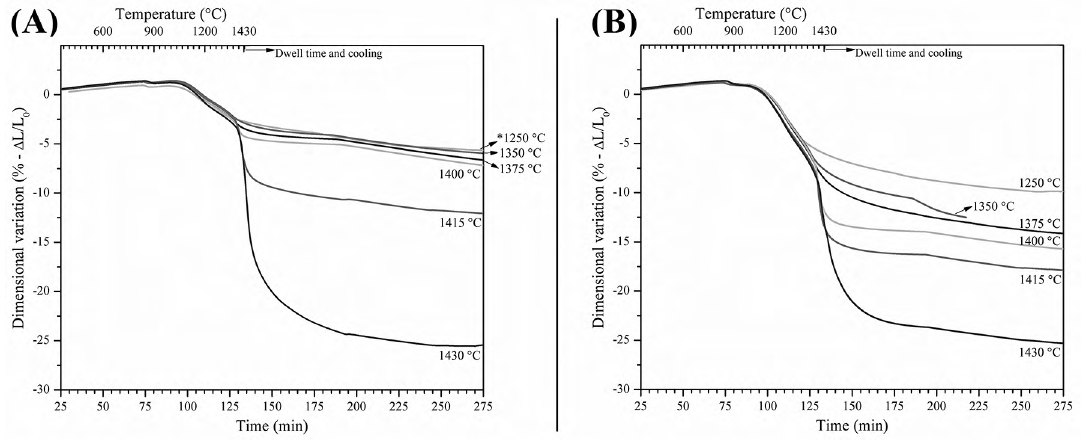
Figure 2. Dimensional behavior of (a) pressed and (b) injection molded samples during their sintering in a dilatometer (heating rate of 10 °C/min up to the sintering temperature in a 5% H